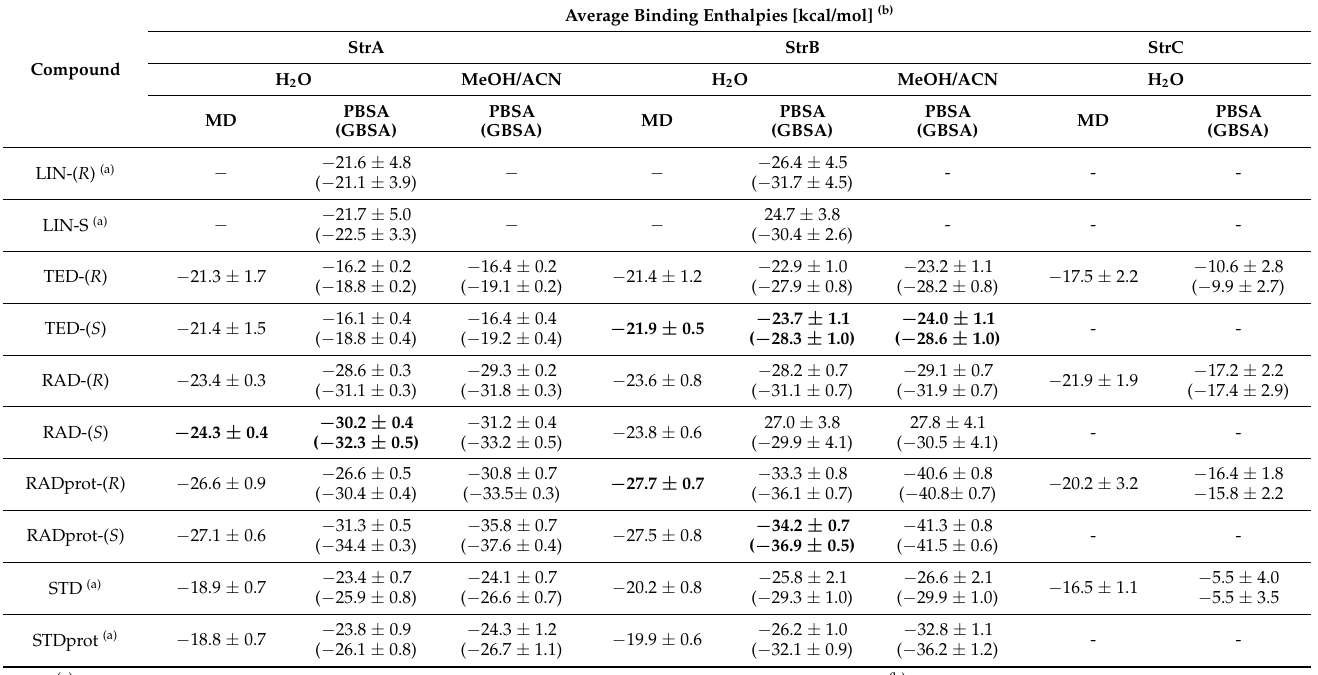
Table 2. Calculated binding average energies (enthalpies) for oxazolidinones complexes with HDAS- β -CD. Averages are calculated only for the time intervals marked in bold in Figure 4. Average Binding Enthalpies [kcal/mol] (b) StrA StrB StrC Compound H 2 O MeOH/ACN H 2